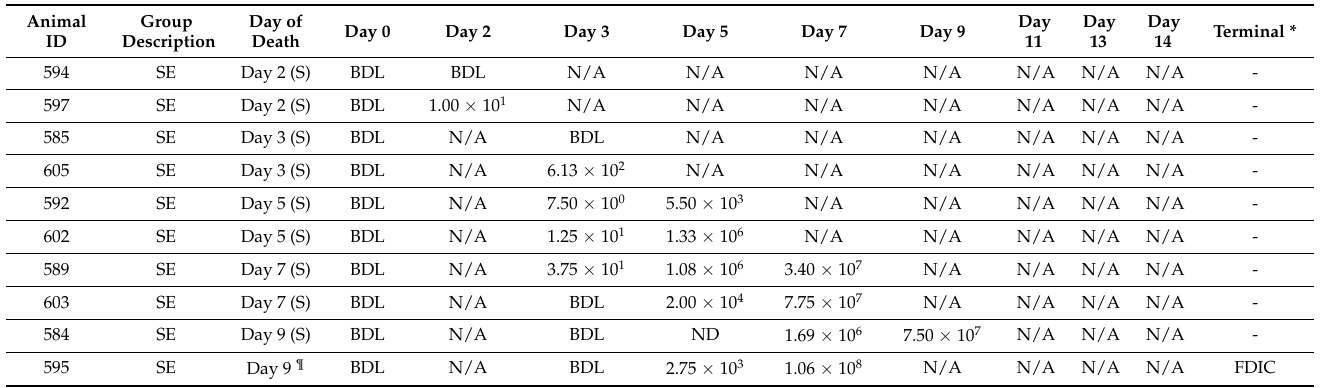
Table 2. Viral load in serum as determined by plaque assay (plaque-forming